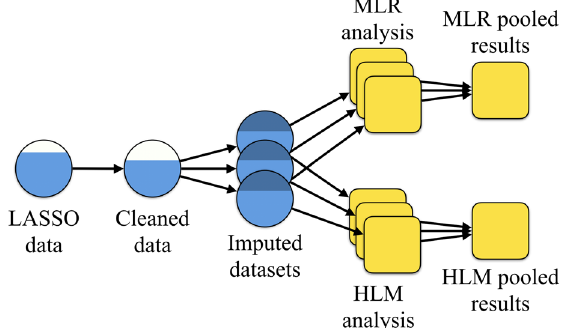
FIG. 2. Work flow for collecting, preparing, and analyzing the data using MLR and HLM. In the circles, blue represents data, white represents missing data, and navy blue represents imputed data. Squares represent